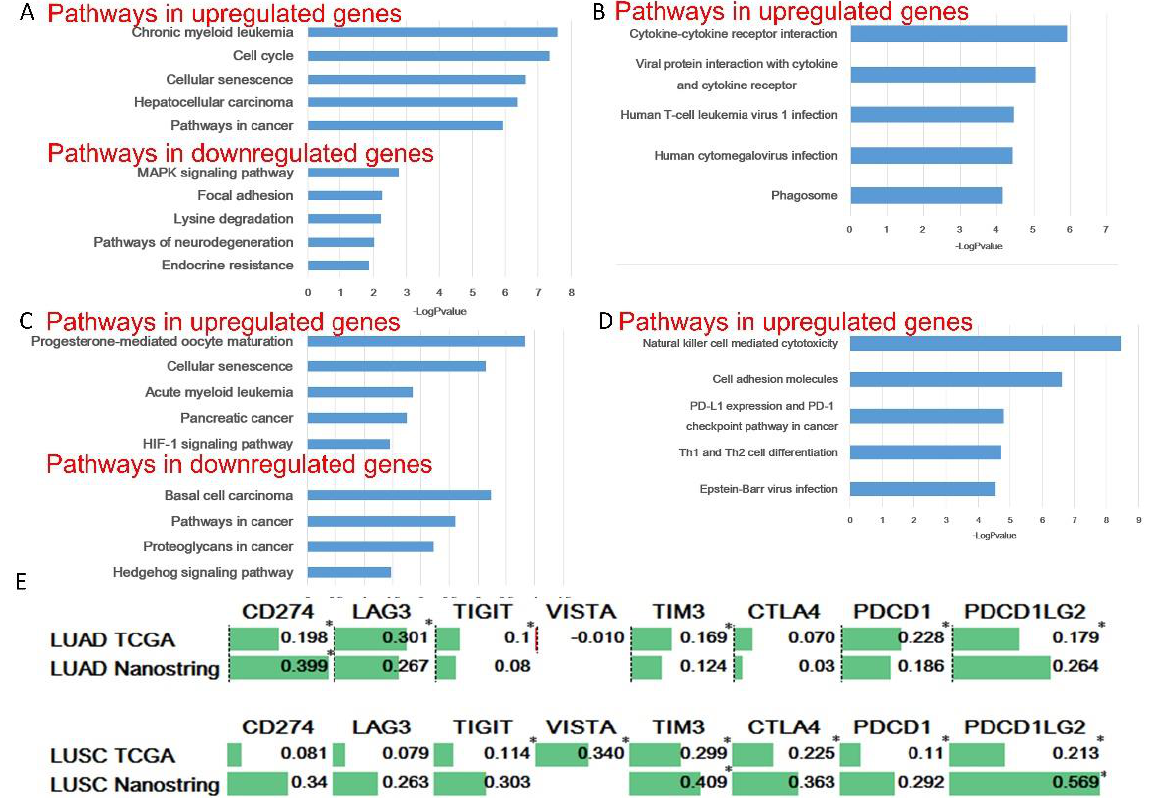
Figure 4. Pathway enrichment analysis of genes associated with responsiveness to PD-1 inhibitor treatment. ( A ) KEGG pathway terms related to intrinsic genes in LUAD. ( B ) KEGG pathway terms related to extrinsic genes in LUAD. ( C ) KEGG pathway terms related to intrinsic genes in LUSC. ( D ) KEGG pathway terms related to extrinsic genes in LUSC. ( E ) Correlation analysis between the intrinsic gene signature and other immune checkpoint targets. LUAD, lung adenocarcinoma; LUSC, lung squamous cell carcinoma; PD-1, programmed cell death protein 1; TCGA, The Cancer Genome Atlas. * Spearman’s rank correlation